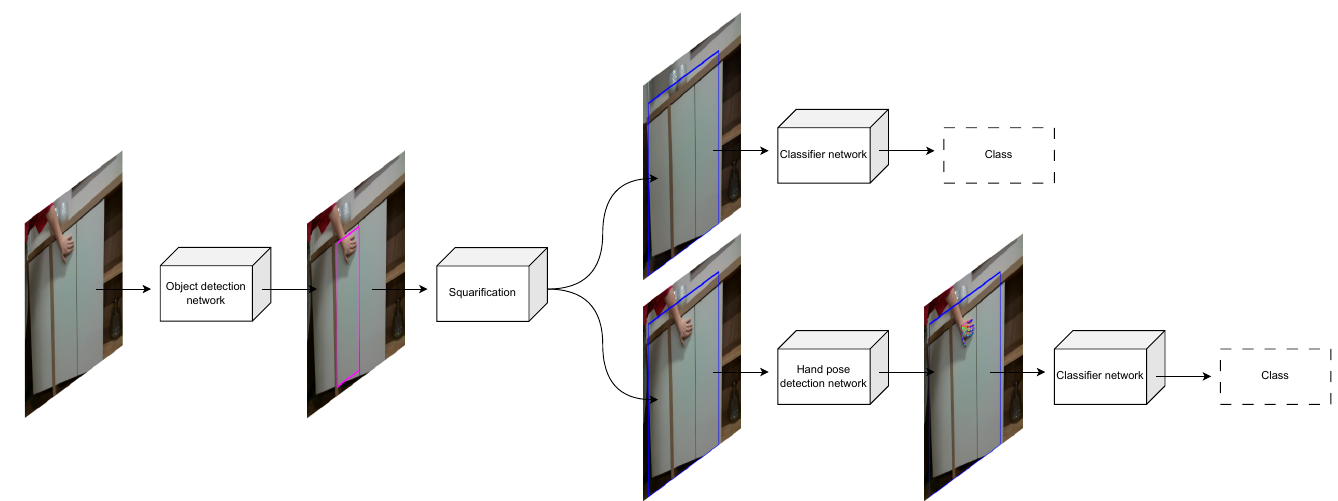
Figure 7. Diagram of the classification method. The top path shows the classification of images without a human hand demonstrating the opening type, while the bottom path shows classification of images with human demonstration.